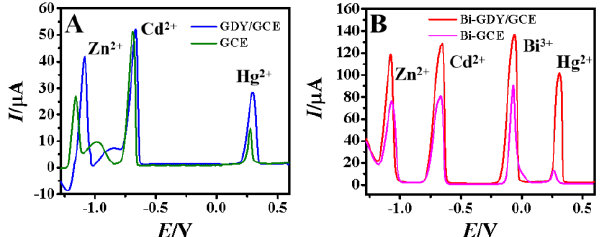
Figure 5. DPASV curves of ( A ) GCE and GDY/GCE in 100.0 μM Zn 2+ , Cd 2+ , Hg 2+ without Bi 3+ and ( B ) GCE and GDY/GCE in 100.0 μM Zn 2+ , Cd 2+ , Hg 2+ solution containing 0.1 mM Bi 3+ . Table 1. The stripping currents of Zn 2+ , Cd 2+ , and Hg 2+ on different working electrodes. Electrodes